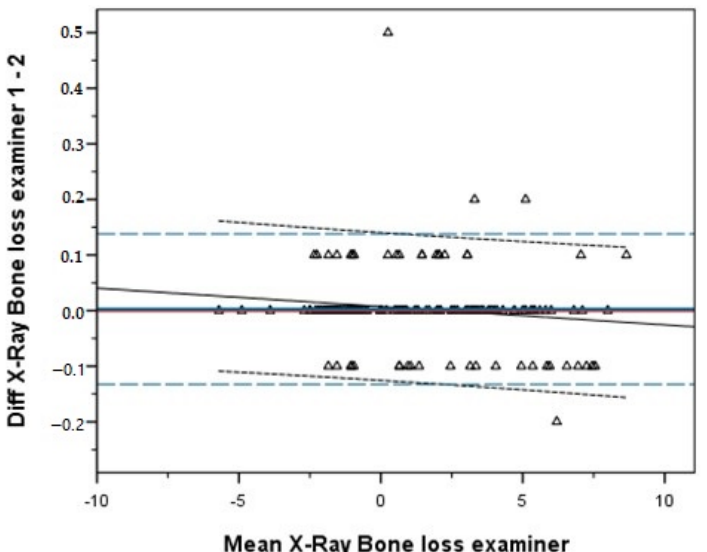
Figure 2. Bland-Altman plot. Figure 3 expresses the change in radiographic bone level at T0, T1, T2, and T3. Globally, the gain of bone at T1, T2, and T3 compared to at T0 was statistically significant ( p < 0.001, ANOVA). Additionally, when comparing pairs (post hoc Bonferroni tests), significance was achieved in all pairs ( p < 0.001).